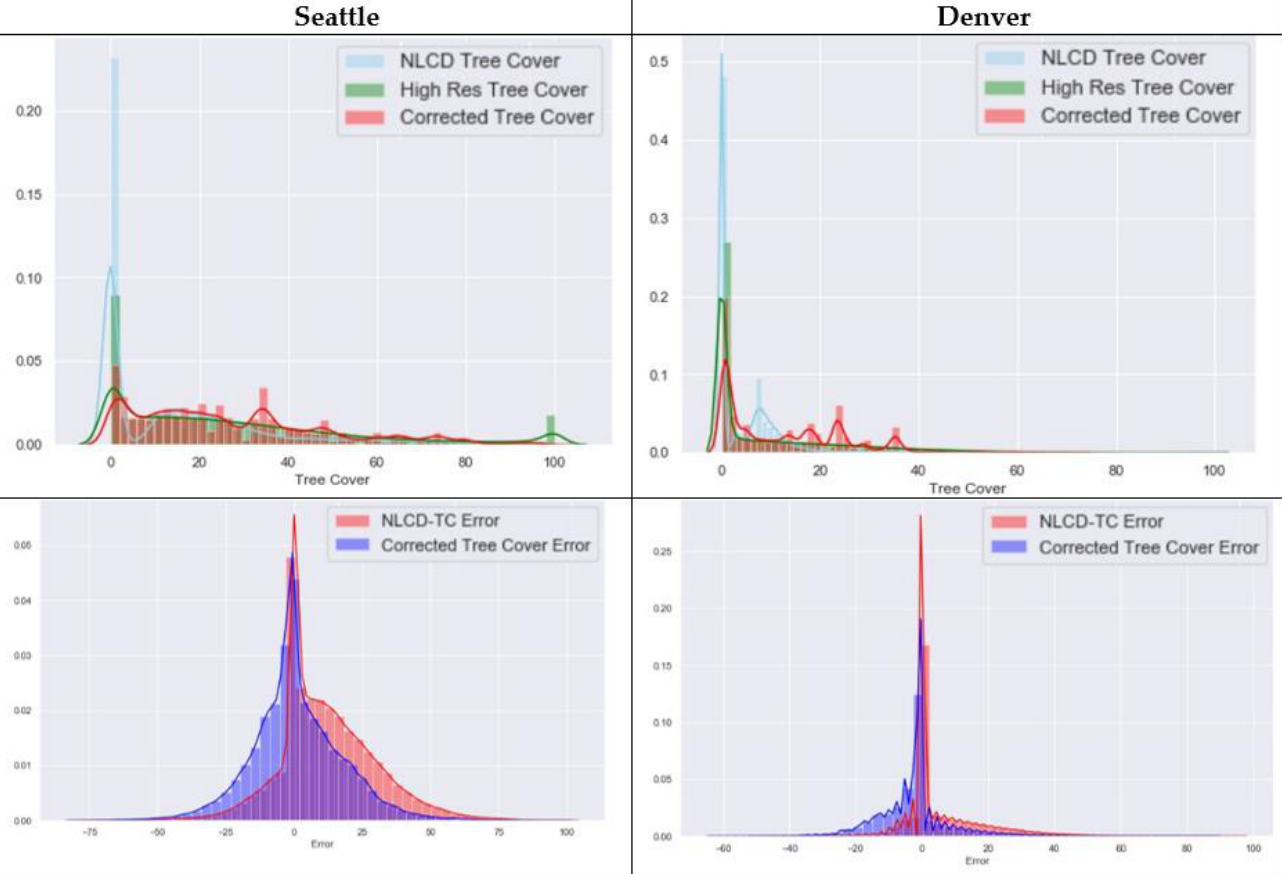
Figure 11. Distribution of tree cover ( top ) and error (deviation by % when compared to high-resolution derived data) ( bottom ) for National Land Cover Database-Tree Canopy (NLCD-TC), high-resolution, and corrected tree cover data in Seattle, WA, and Denver, CO; the smoothed lines are the normal density lines.